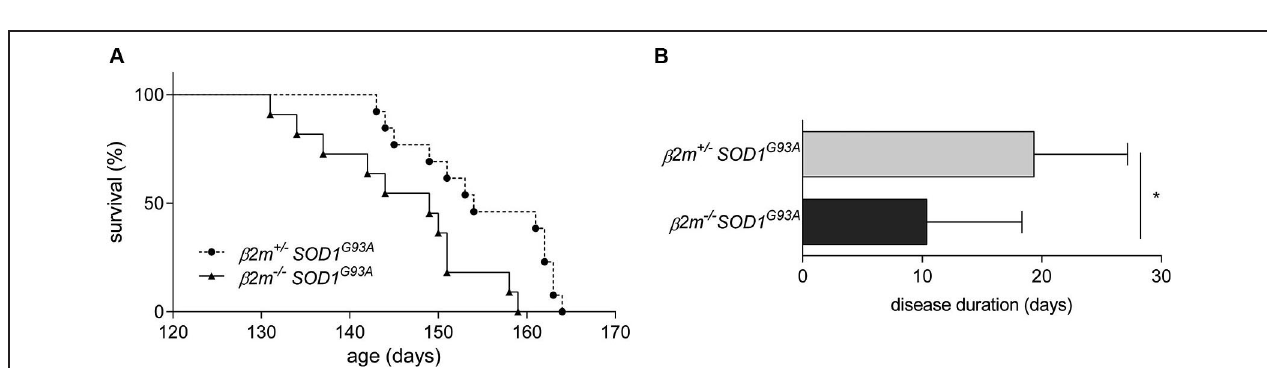
FIGURE 1 | Increased β 2 m gene expression in ALS mice . (A) Relative β 2 m gene expression in spinal cord of non-transgenic (ntg, n = 6) and SOD1 WT controls ( n = 6) compared to presymtomatic (presympt, n = 6), symptomatic (sympt, n = 6) and end stage ( n = 6) SOD1 G 93 A mice (ANOVA, Bonferroni post hoc). (B) Relative β 2 m gene expression in neurons isolated by laser dissection microscopy from the spinal cord